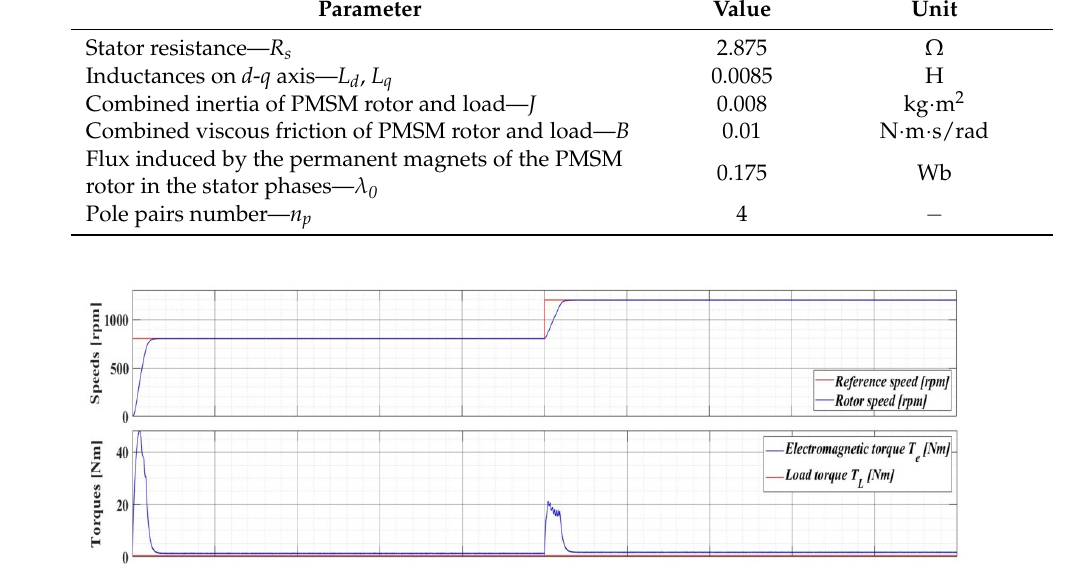
Figure 5. Image of the phase plan: rotor speed versus i d current. Figure 6. Image of the phase plan: rotor speed versus i q current.